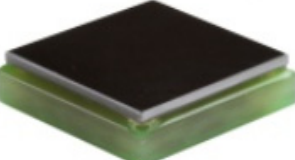
Figure 2. Ionizing radiation sensor (source: www.first-sensor.com).